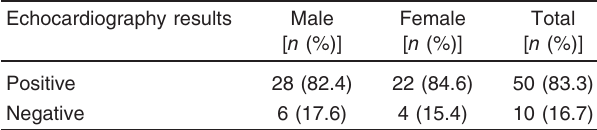
Table 5 Echocardiography results of pulmonary hypertension in all cases